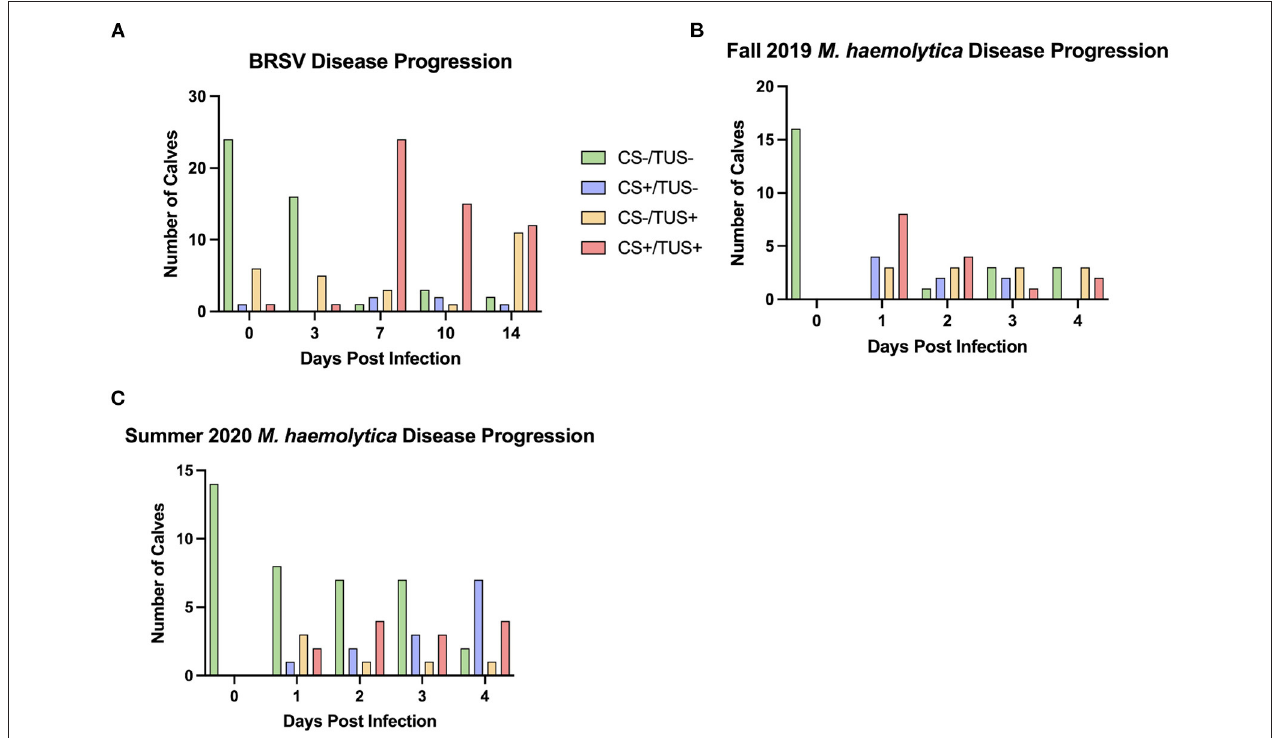
FIGURE 5 | The distribution of calves represented in each of the four quadrants over the course of BRSV (A) and M. haemolytica (B,C) infection. For the BRSV-infected calves (A) , TUS was performed on days 0, 3, 7, 10, and 14 after infection. For the M. haemolytica –infected calves (B,C) , TUS was performed on days 0, 1, 2, 3, and 4 after infection.